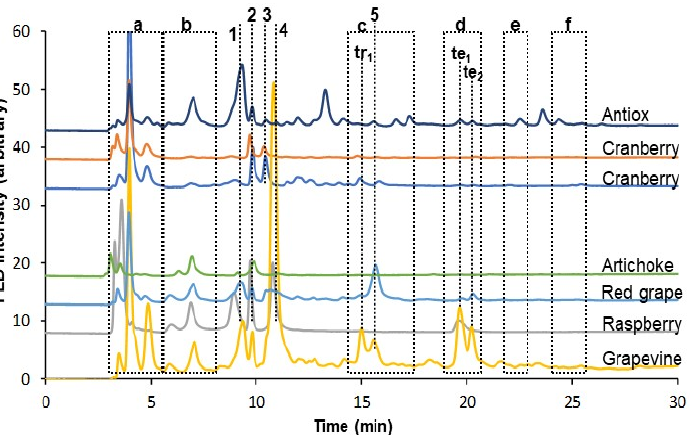
Figure 2. Representative chromatograms of various nutraceutical samples obtained by the HILIC with fluorescence detection. Sample assignation: deep blue = antiox; orange = cranberry; blue = cranberry (combined); green = artichoke; light blue = red grape (peel and seeds); grey = raspberry and yellow = grapevine. Compound assignation from standards: 1 = catechin; 2 = epicatechin; 3 = procyanidin A2; 4 = procyanidin B2 and 5 = procyanidin C1. Tentative compound assignation: a = phenolic acids; b = other flavonoids; c = trimers (tr 1 = trimer 1); d = tetramers (te 1 = tetramer 1; te 2 = tetramer 2); e = pentamers and f = hexamers.